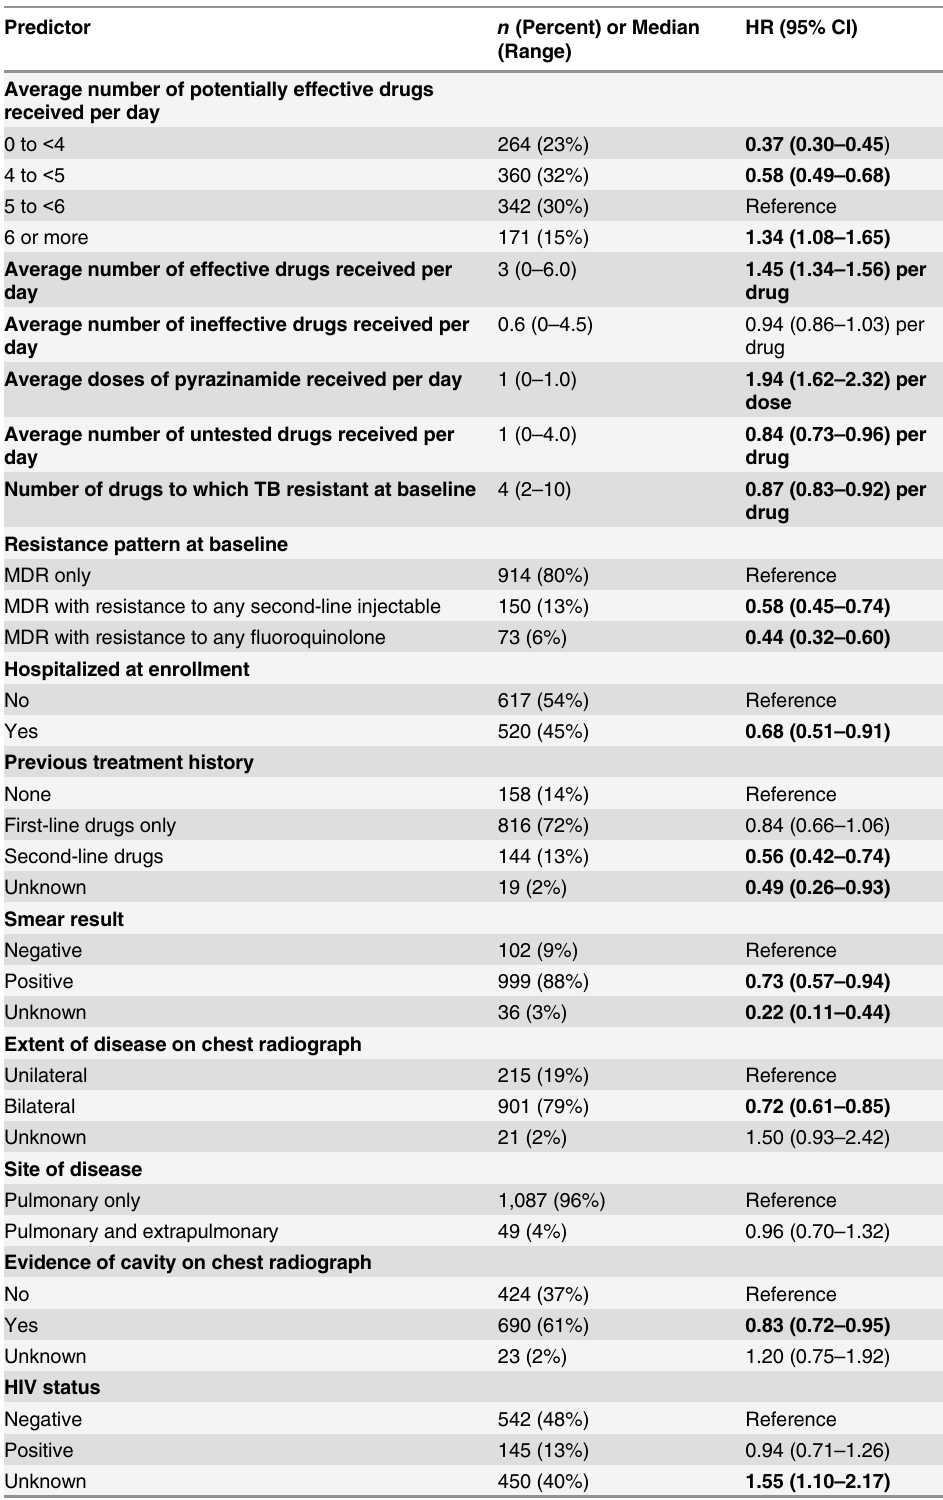
Table 2. Patient characteristics and univariate associations with sputum culture conversion among patients treated for MDR TB ( n =